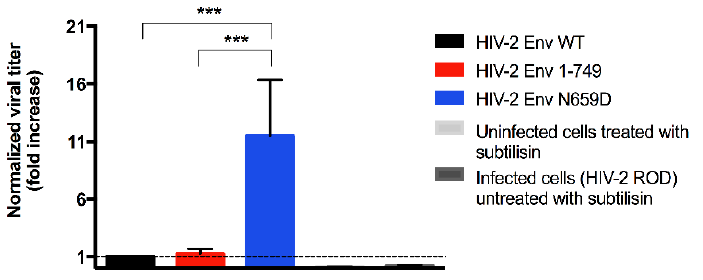
Figure 4. At three days post-infection, infected H9 cells were conserved and then treated with the bacterial protease subtilisin that released the tethered virions. Graph shows relative quantification of viral particles tethered at the cell surface. Data for the HIV-2 Env WT has been normalized to 1 (dashed line in the graph). Data for the others viruses has been compared to this normalized value and has been expressed as folds increase. Error bars indicate mean ± SD for n = 4 independent experiments. Statistical tests (one-way ANOVA followed by Tukey’s multiple comparisons test) give statistical significance with a p < 0.001 (***) both for Env WT and Env N659D viruses, and for Env 1–749 and Env N659D viruses. There is no statistical significance in titer between the Env WT and Env 1–749 viruses. Two negative controls were also tested: a medium from uninfected H9 cells treated with subtilisin, and a medium from infected H9 cells untreated with